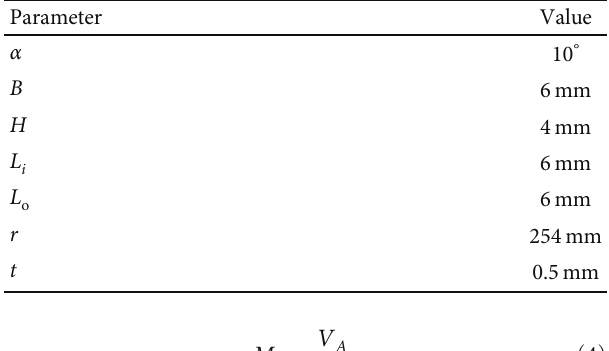
Table 1: Geometric